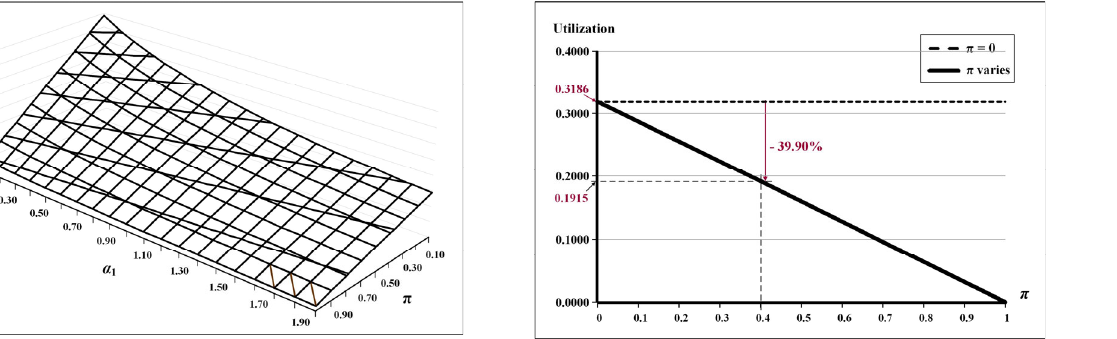
Fig. 13. Collective influence of difference in α 1 and π on Fig. 14. Impact of differences in π on utilization utilization